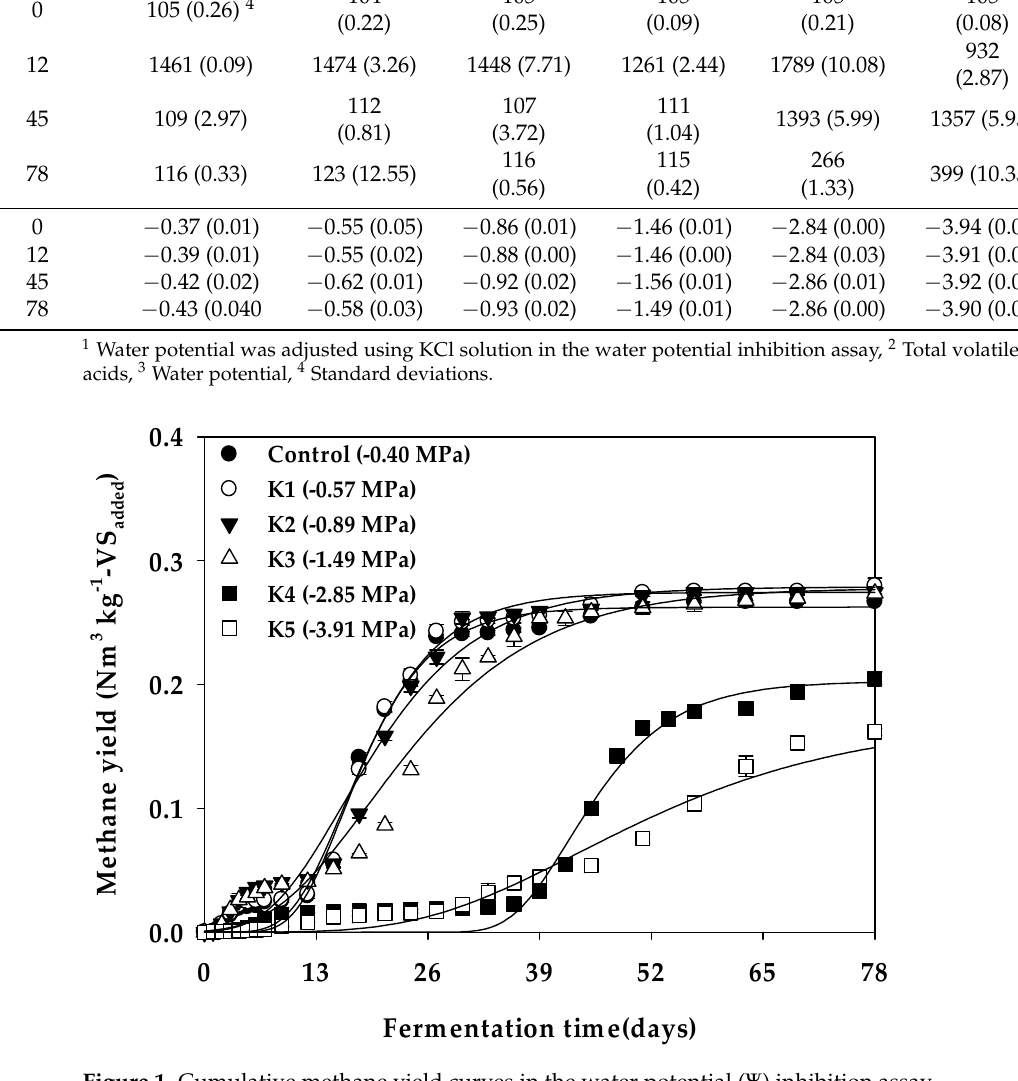
Figure 1. Cumulative methane yield curves in the water potential ( Ψ ) inhibition assay. Table 7. Ultimate methane yield and the parameters calculated with the modified Gompertz model for the water potential ( Ψ ) inhibition assay.